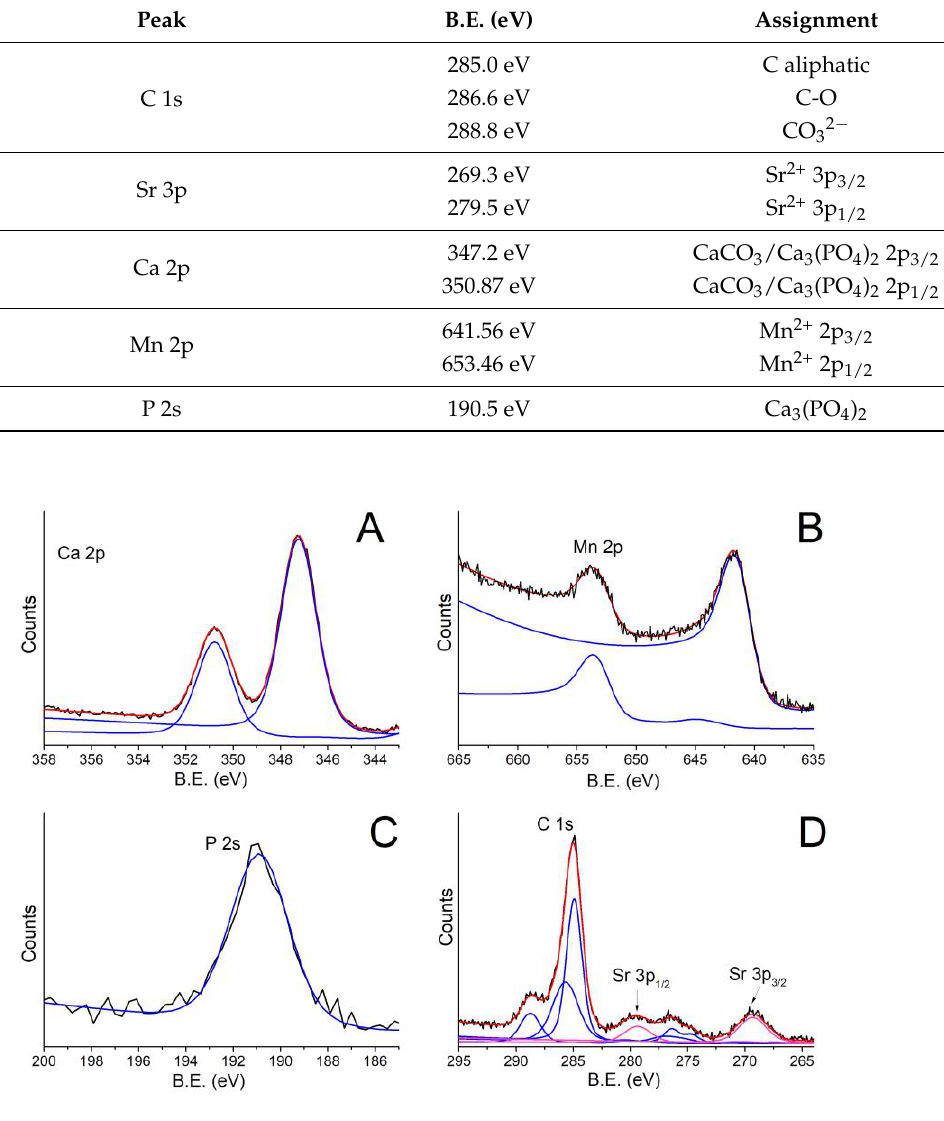
Table 1. XPS analysis results obtained for Mn,Sr-TCP coating.